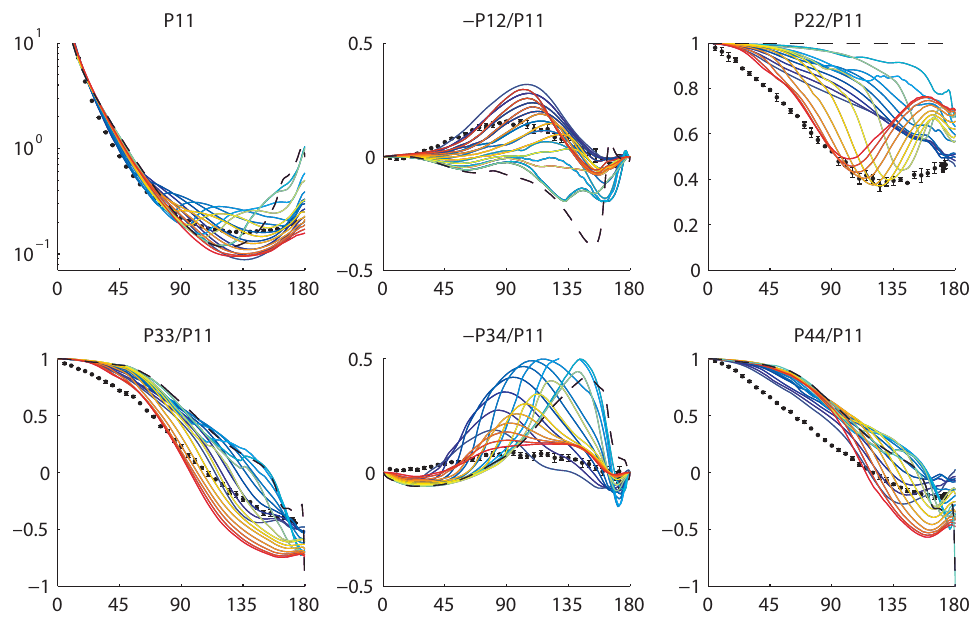
Fig. 1. Measured and simulated scattering-matrix elements for the loess sample at wavelength λ = 632 . 8nm. The measurements are shown with small black dots and their error bars. Different solid lines depict scattering by different spheroids with refractive index of m = 1 . 55 + 0 . 001 i , ranging from prolate (red) to oblate (blue) aspect. The dashed black line is the corresponding simulation for a